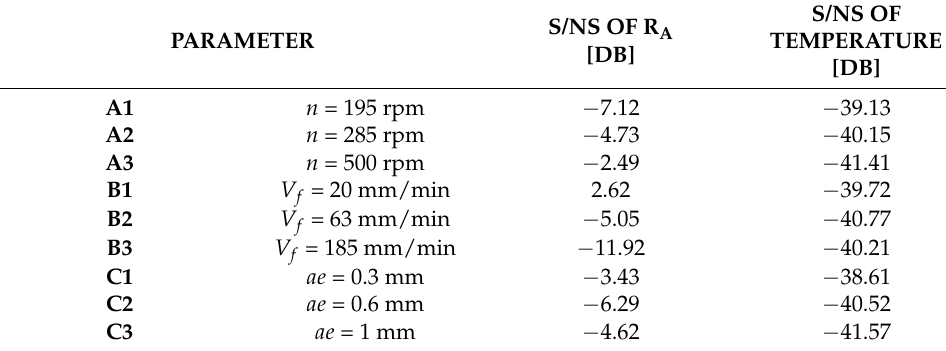
Table 6. S/Ns for each parameter in the dry machining tests.